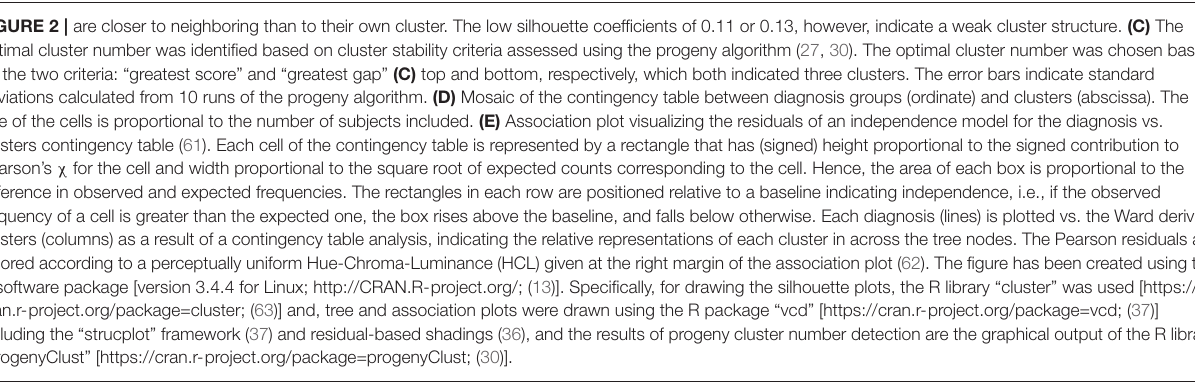
FIGURE 2 | are closer to neighboring than to their own cluster. The low silhouette coefficients of 0.11 or 0.13, however, indicate a weak cluster structure. (C) The optimal cluster number was identified based on cluster stability criteria assessed using the progeny algorithm (27, 30). The optimal cluster number was chosen based on the two criteria: “greatest score” and “greatest gap” (C) top and bottom, respectively, which both indicated three clusters. The error bars indicate standard deviations calculated from 10 runs of the progeny algorithm. (D) Mosaic of the contingency table between diagnosis groups (ordinate) and clusters (abscissa). The size of the cells is proportional to the number of subjects included. (E) Association plot visualizing the residuals of an independence model for the diagnosis vs. clusters contingency table (61). Each cell of the contingency table is represented by a rectangle that has (signed) height proportional to the signed contribution to Pearson’s χ for the cell and width proportional to the square root of expected counts corresponding to the cell. Hence, the area of each box is proportional to the difference in observed and expected frequencies. The rectangles in each row are positioned relative to a baseline indicating independence, i.e., if the observed frequency of a cell is greater than the expected one, the box rises above the baseline, and falls below otherwise. Each diagnosis (lines) is plotted vs. the Ward derived clusters (columns) as a result of a contingency table analysis, indicating the relative representations of each cluster in across the tree nodes. The Pearson residuals are colored according to a perceptually uniform Hue-Chroma-Luminance (HCL) given at the right margin of the association plot (62). The figure has been created using the R software package [version 3.4.4 for Linux; http://CRAN.R-project.org/; (13)]. Specifically, for drawing the silhouette plots, the R library “cluster” was used [https:// cran.r-project.org/package=cluster; (63)] and, tree and association plots were drawn using the R package “vcd” [https://cran.r-project.org/package=vcd; (37)] including the “strucplot” framework (37) and residual-based shadings (36), and the results of progeny cluster number detection are the graphical output of the R library “progenyClust” [https://cran.r-project.org/package=progenyClust;